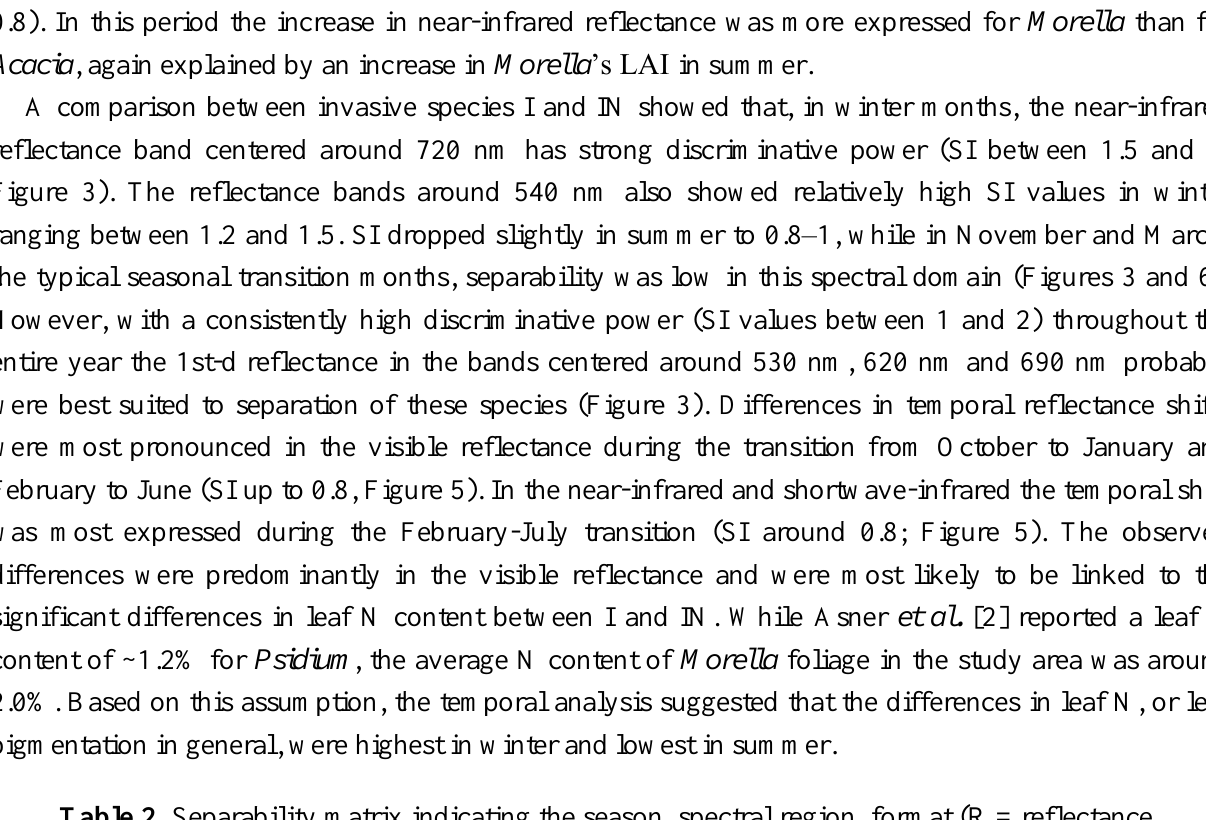
Table 2. Separability matrix indicating the season, spectral region, format (R = reflectance, D = derivative reflectance, T = temporal displacement spectra) and SI value for the period of greatest overall